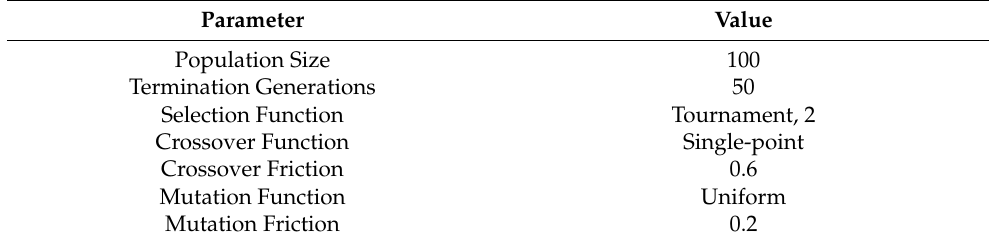
Table 3. Settings for the genetic